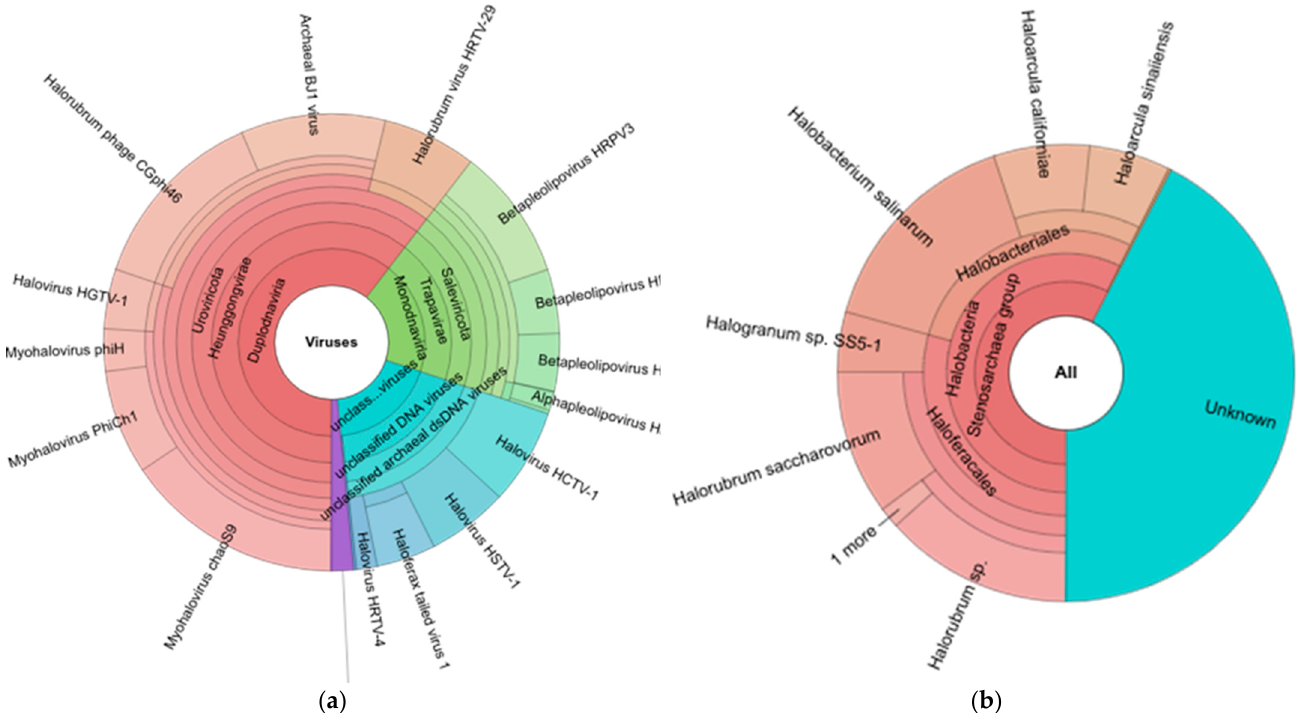
Figure 3. ( a ) Halo virus species and ( b ) Microorganism host of halo virus in brine sample detected by Genome Detective server.